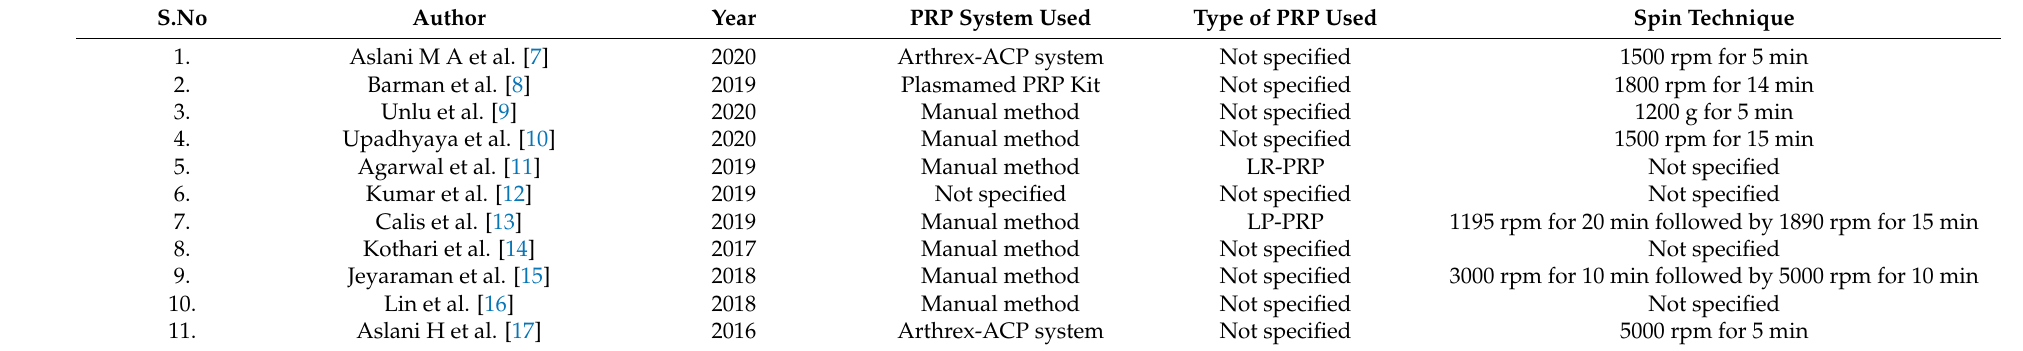
Table 2. Details of isolation protocols of PRP in the included